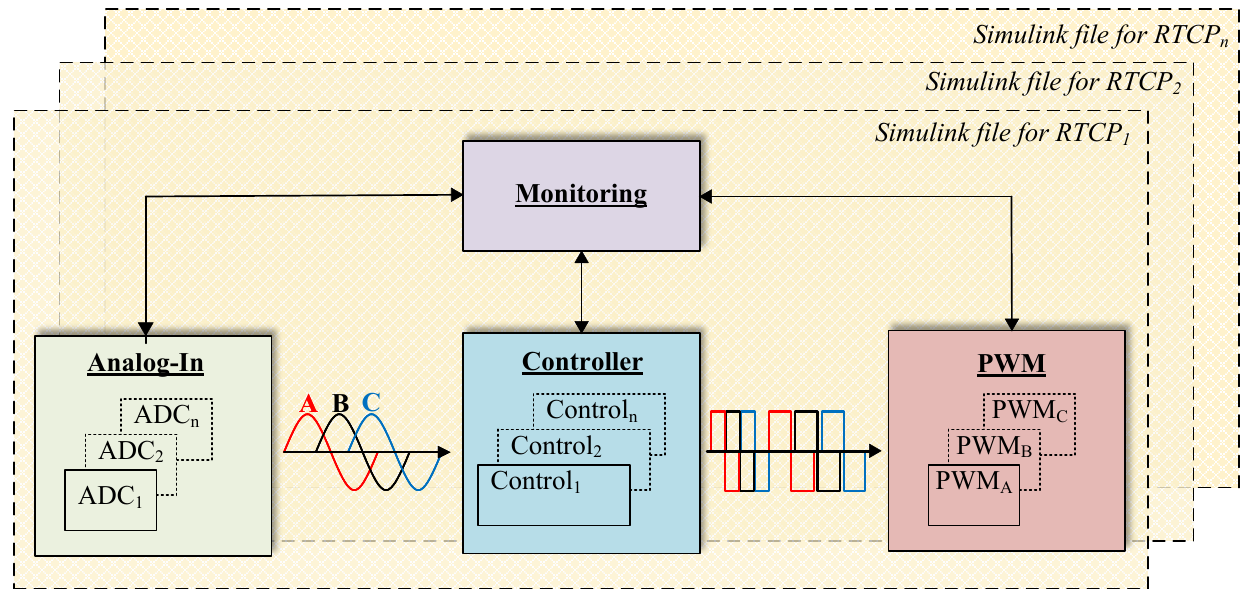
Figure 8. General structure of the Matlab/Simulink files for each controller